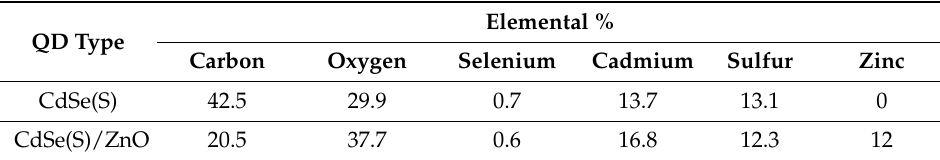
Table 1. Elemental analysis of